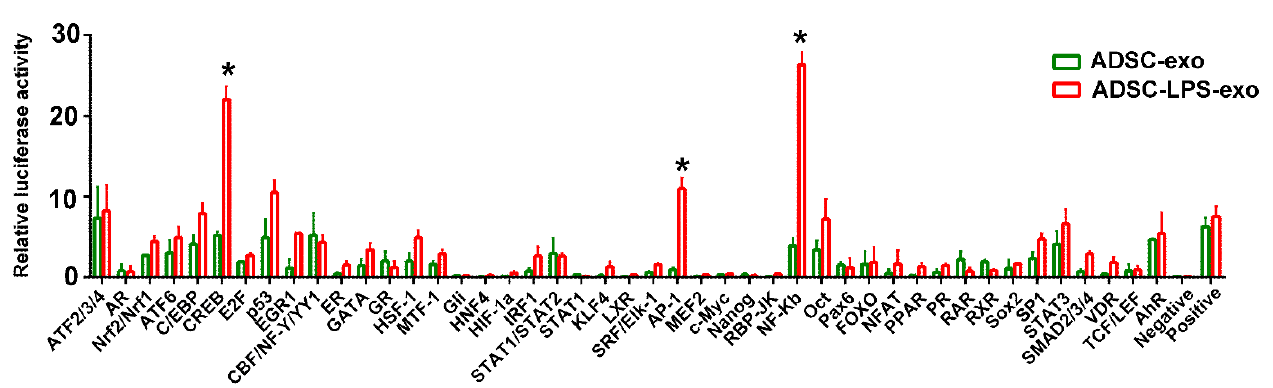
Figure 3. Activated signal transduction pathways in Cignal Finder Reporter Arrays at 24 h after the uptake of ADSC-LPS-exo into HUVECs, compared to those treated with ADSC-exo. The reporter array had 45 inducible transcription factor-responsive constructs, which controlled firefly luciferase reporter gene expression, in duplicate, in a 96-well plate. The Renilla luciferase gene was included in the wells for the normalization of transfection efficiency. (*, a p -value < 0.05 with at least 5-fold expression of the luminescence).